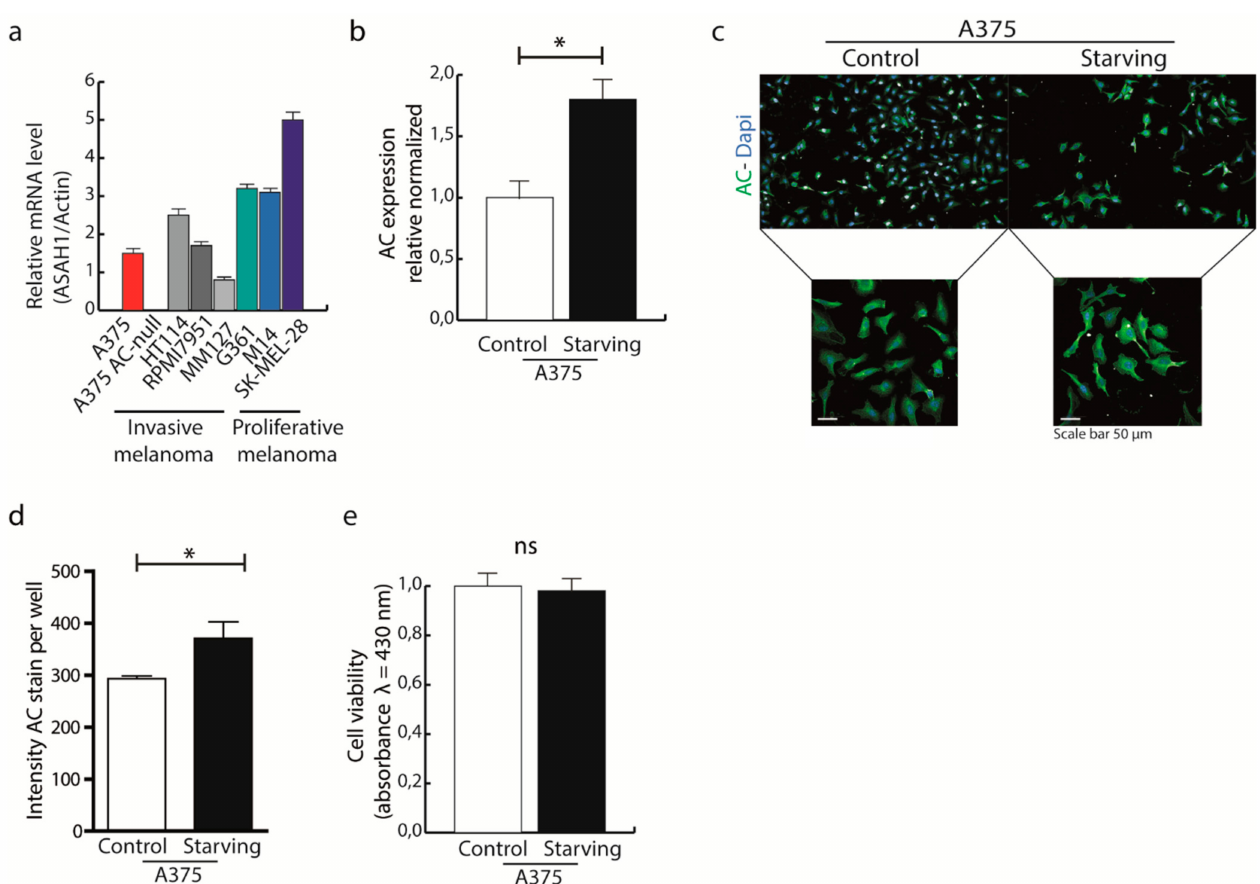
Figure 1. AC expression increases during starvation. ( a ) AC expression in invasive melanomas (A375, HT114, RPMI7951, MM1277) and proliferative melanomas (G361, M14, SK-MEL28). ( b ) A375 melanoma cells were incubated with starving medium for 24 h, AC transcription was measured by Real-time PCR. Results are expressed as mean ± SD, with each experiment performed with two biological and three technical replicates (* p < 0.05, Student’s t- test). ( c ) A375 were incubated in normal or starving conditions for 24 h. Cells were then fixed, stained for AC and visualised using Operetta High Content Imaging System. Staining intensity was analysed using Harmony Software. ( d ) Analysis of AC intensity in A375 cells exposed or not to starving conditions. Results are expressed as mean ± SD, with each experiment performed with two biological and three technical replicates (* p < 0.05, Student’s t- test). ( e ) A375 cells were incubated with starving medium for 24 h and cell viability was assessed using the Alamar Blue assay ( λ = 430 nm). Results are expressed as mean ± SD, with each experiment performed with two biological and three technical replicates ( p < 0.05, Student’s t-